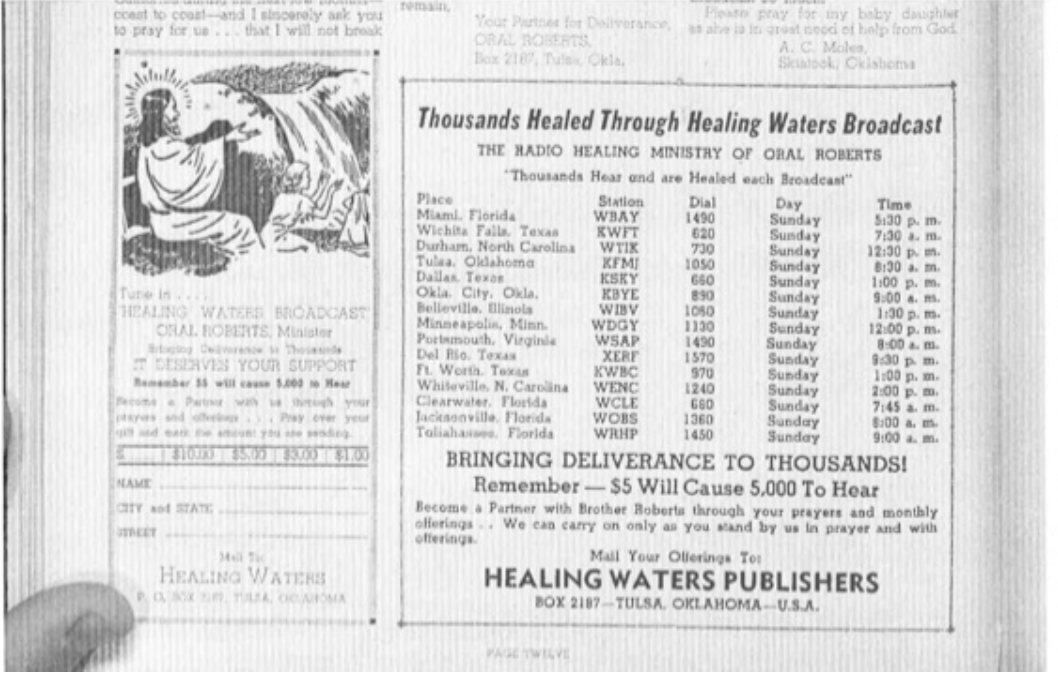
Figure 5 . Advertisement from the Healing Waters Magazine. Figure 5. Advertisement from the Healing Waters Magazine . Religions 2016 , 7 , 69